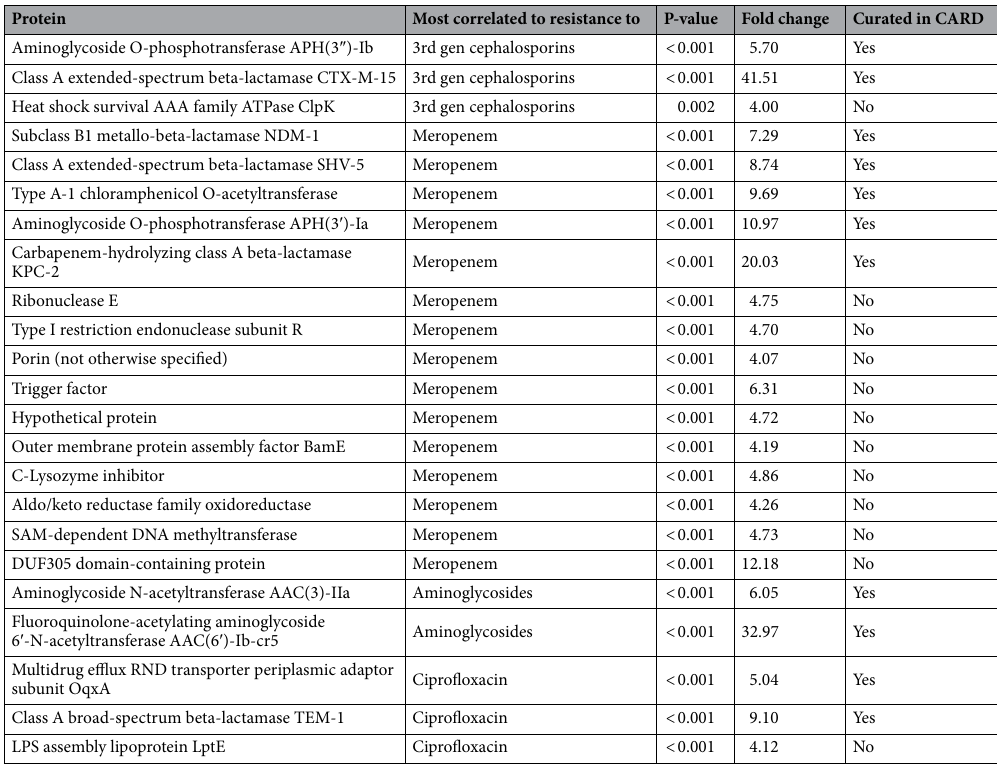
Table 6. All protein groups which were more than 4 times as abundant in resistant K. pneumoniae isolates compared to susceptible K. pneumoniae